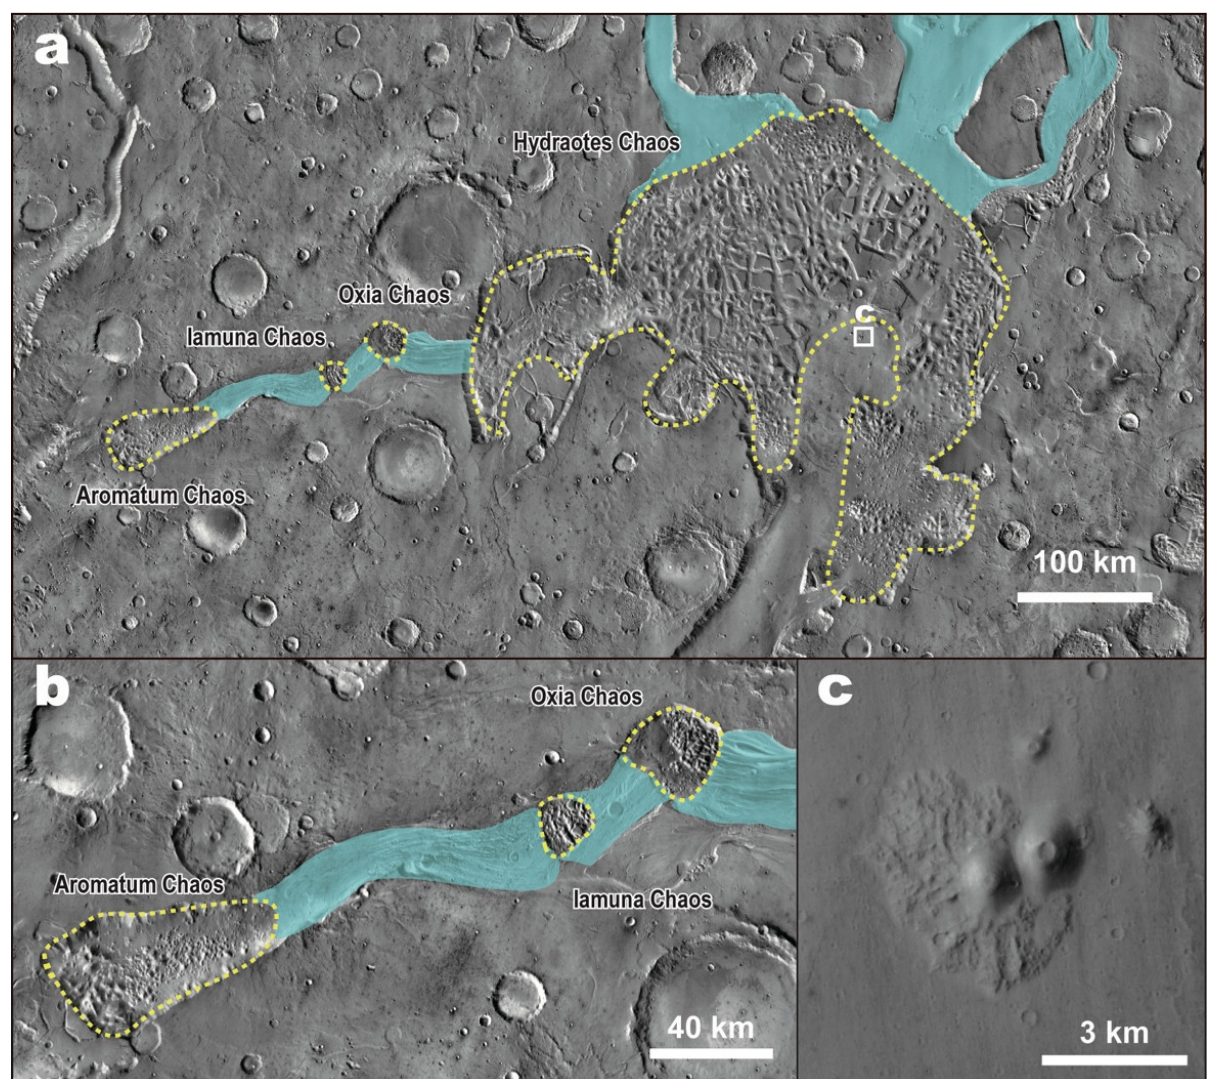
Figure 2. ( a ) A THEMIS daytime infrared image of Aromatum Chaos, Hydraotes Chaos, Iamuna Chaos, and Oxia Chaos. The areas surrounded by the yellow dotted line indicate the chaos terrains. The chaos terrains are connected to outflow channels (the area colored light blue). The white box indicates the location of the pitted cones shown in panel ( c ). ( b ) A THEMIS daytime infrared image of the Ravi Vallis outflow channel system. The outflow channel system seems to originate from Aromatum Chaos and Iamuna Chaos. ( c ) A close-up CTX image of a pitted cone near Hydraotes Chaos.